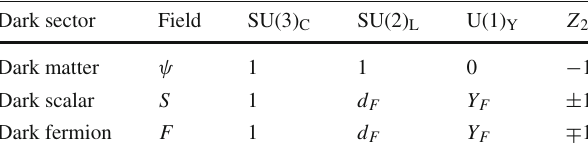
Table 2 Particle content and quantum numbers of the Majorana DM scenariowithadarkfermionandadarkscalar.Thedarksectorischarged under a Z 2 symmetry which stabilizes the DM